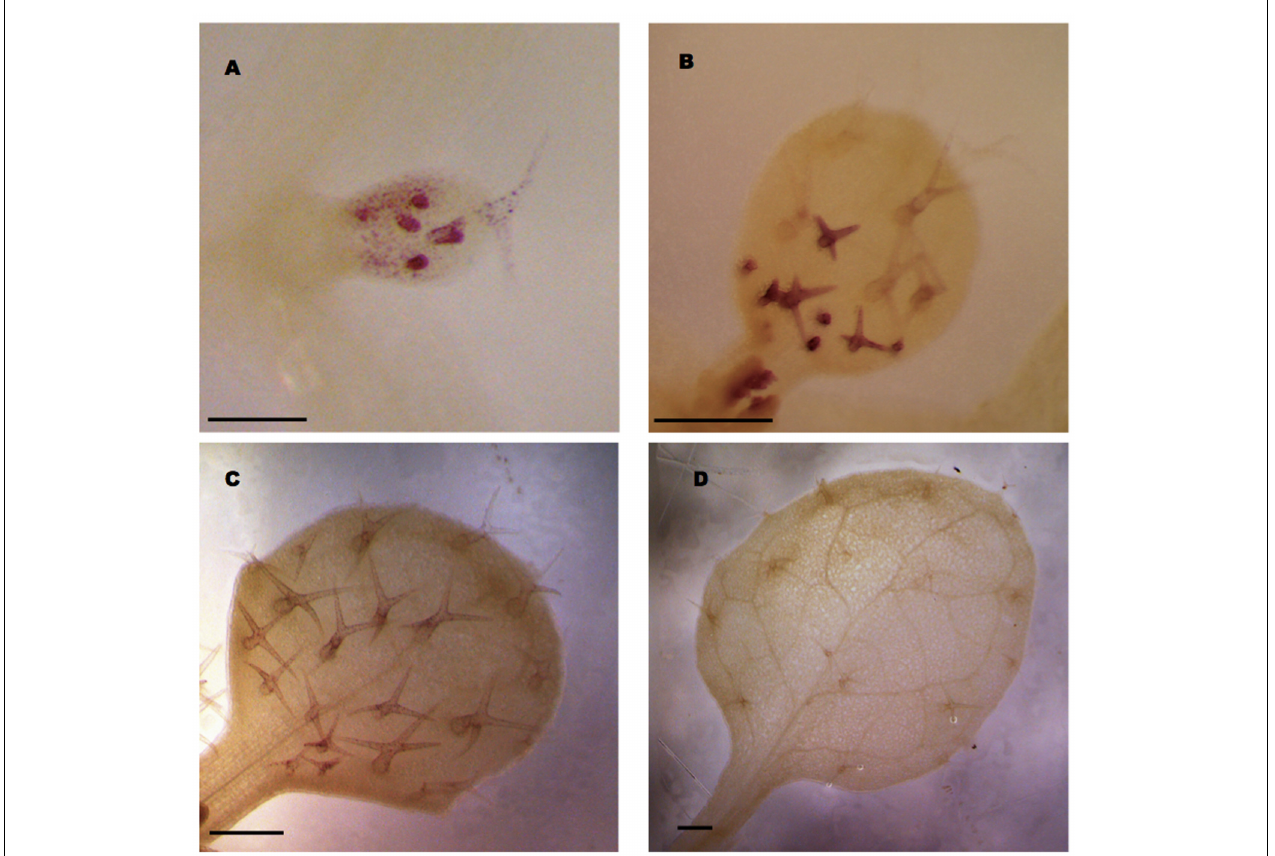
FIGURE 4 | GL3 expression as revealed by pGL3:GL3(intron2)-GUS. Glucuronidase activity was detected in the first or second true leaves using magenta Glc-A as a substrate. (A) Incipient leaf with six trichomes at different stages 4 days after germination (DAG). (B) Young leaf with young stained trichomes at the leaf base and weakly stained older trichomes at the leaf tip 6 DAG. (C) Ten days old mature leaf with weakly stained trichomes. (D) Fourteen days old leaf with mature unstained trichomes. Scale bars in (A–C) are 100 µ m. Scale bar in (D) is 200 µ